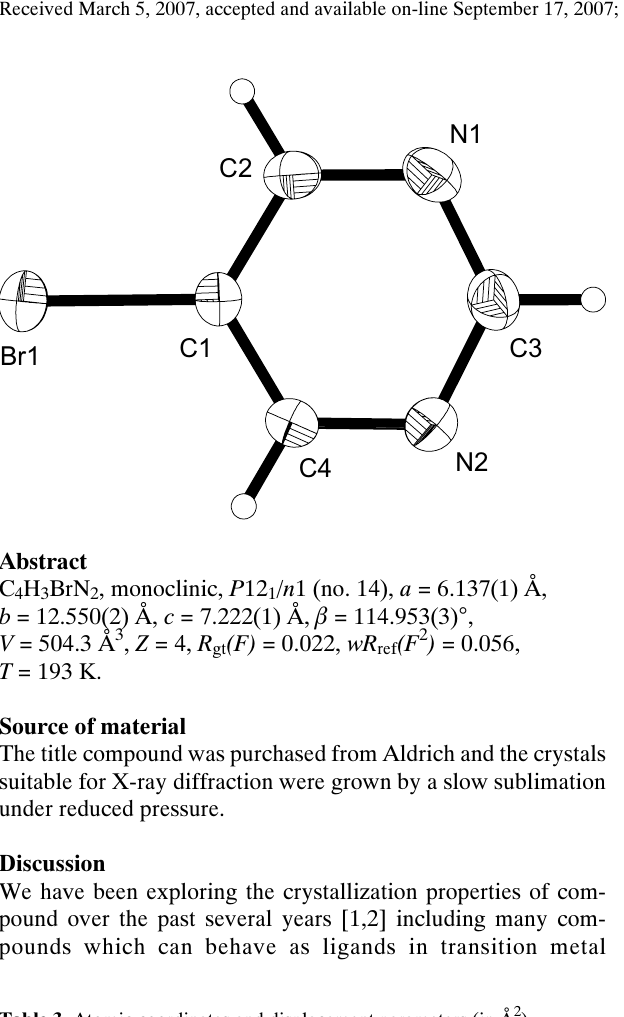
Table 3. Atomic coordinates and displacement parameters (in Å 2 ) .